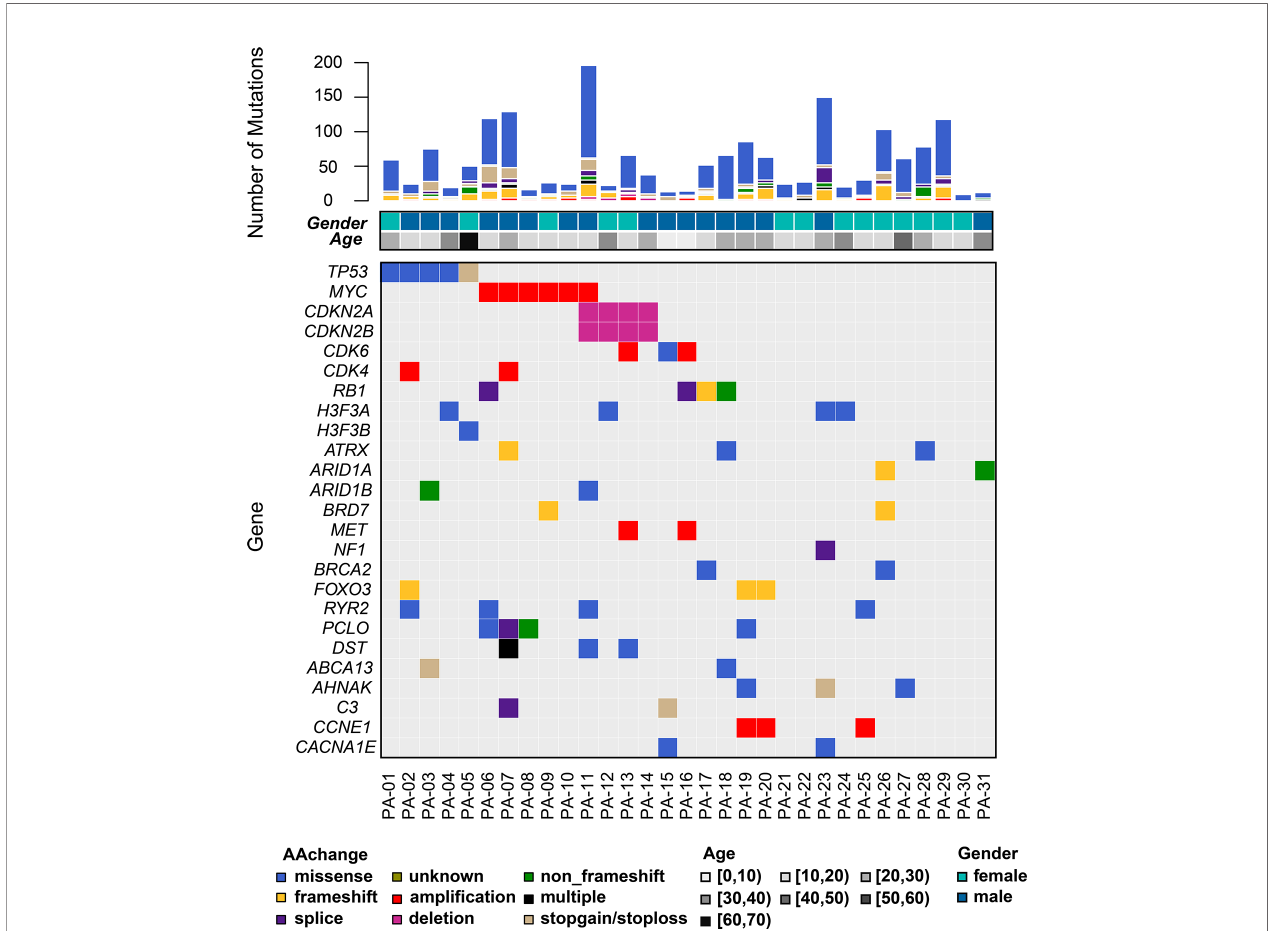
FIGURE 1 | The mutational landscape of somatic alterations. Mutated genes are listed on the left-side. The genes with the mutations occurring ≥ 4 per sample and reported driver genes were included. Each column represents a sample. Top bar plot summarizes the numbers of mutations per sample shown with corresponding age and gender. Different colors refer to mutational types and ages at low